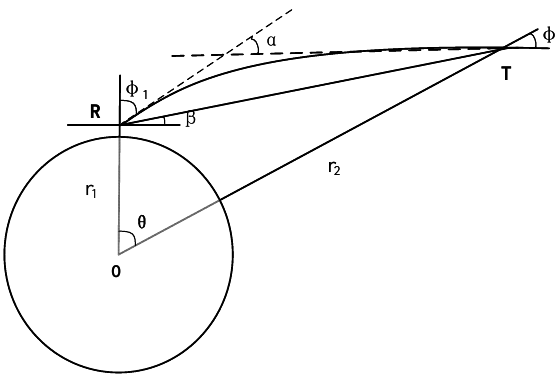
Figure 1. Geometry of ground-based Global Positioning System (GPS) occultation for computing phase-delay.